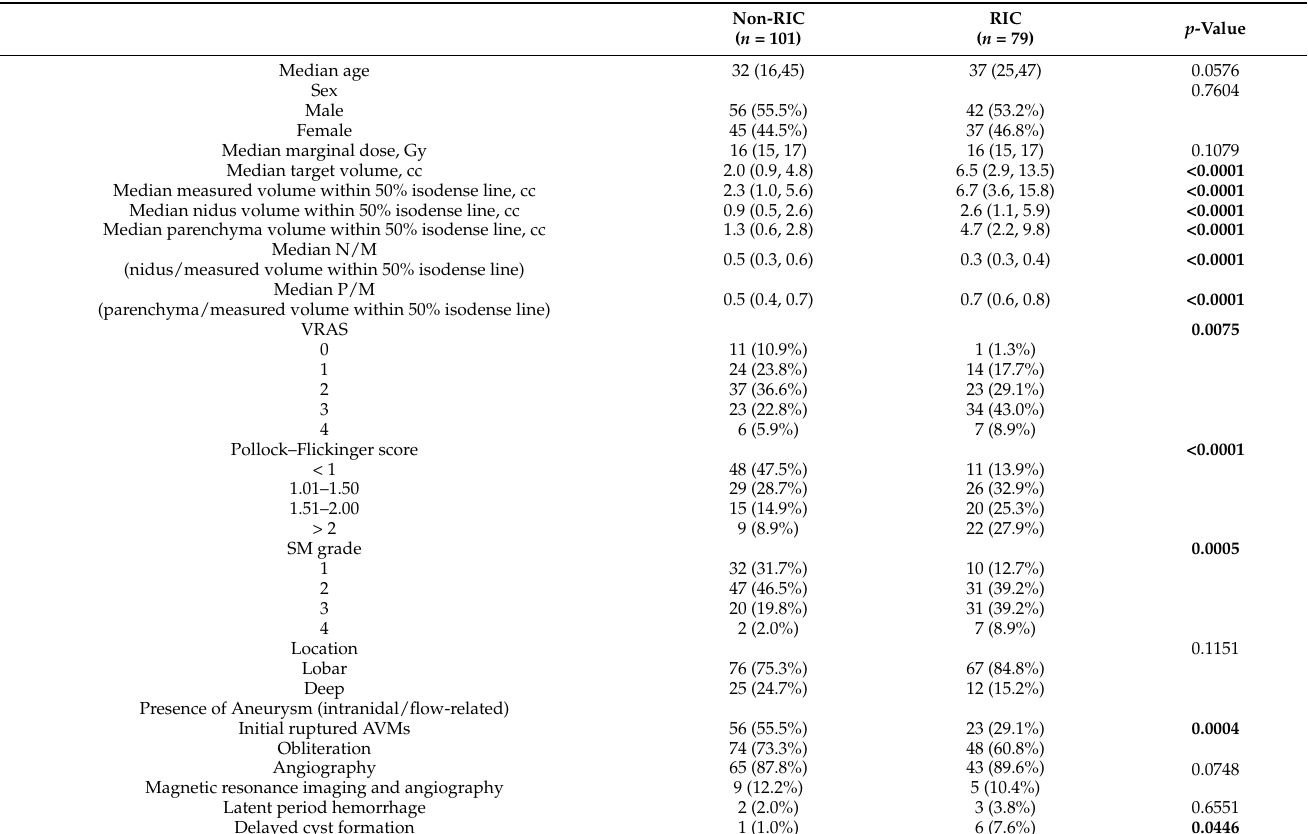
Table 2. Comparison of baseline demographic data, arteriovenous malformation (AVM) characteristics, radiosurgical parameters, and treatment outcomes between the radiation-induced change (RIC) group and non-RIC